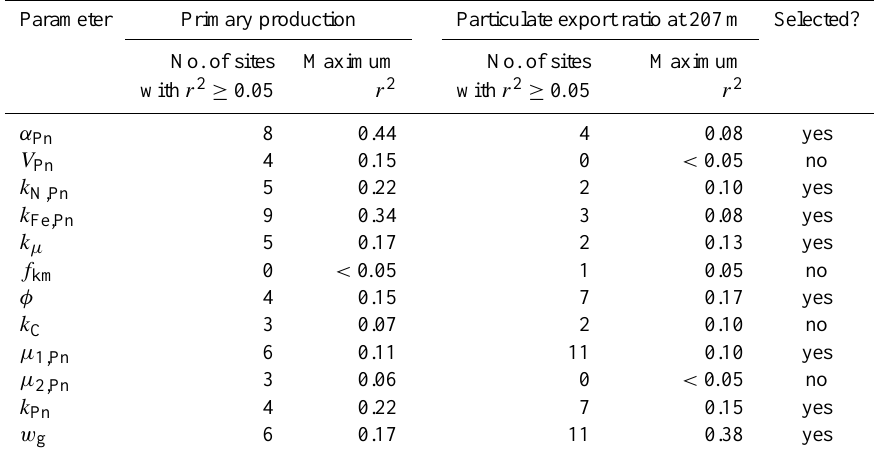
Table A5. Parameter sensitivity of annual mean model output from 28-dimensional analysis, showing parameters that explain 5% or more of the variance in either variable at one or more